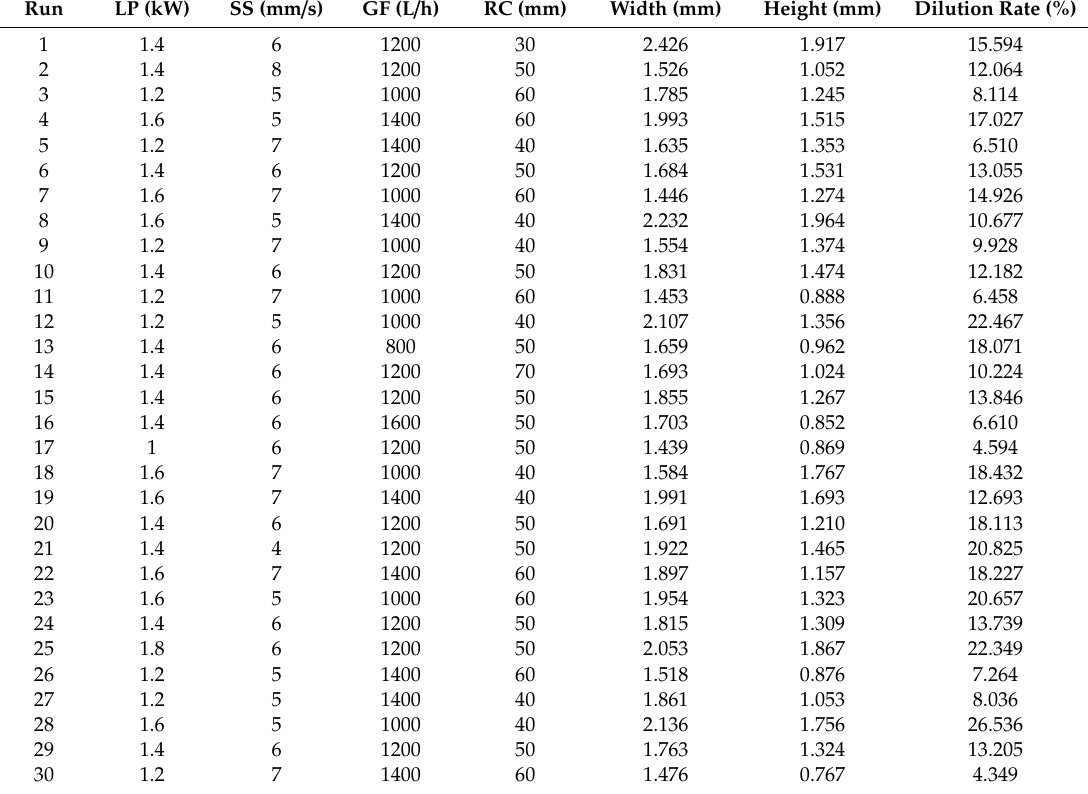
Table 3. Experimental design and